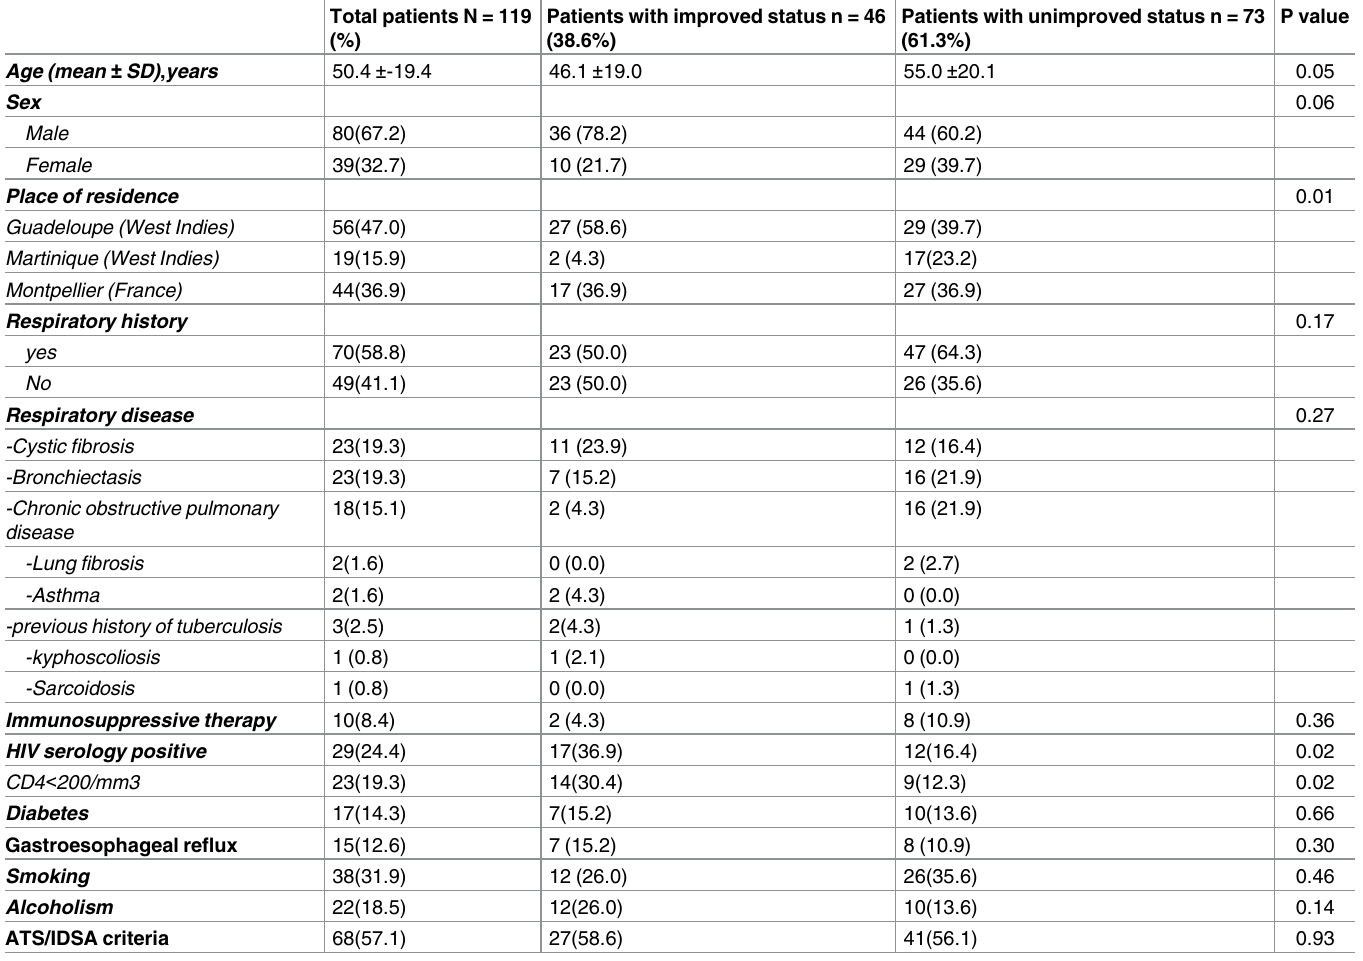
Table 1. The general characteristics of patients with improved versus unimproved status at one